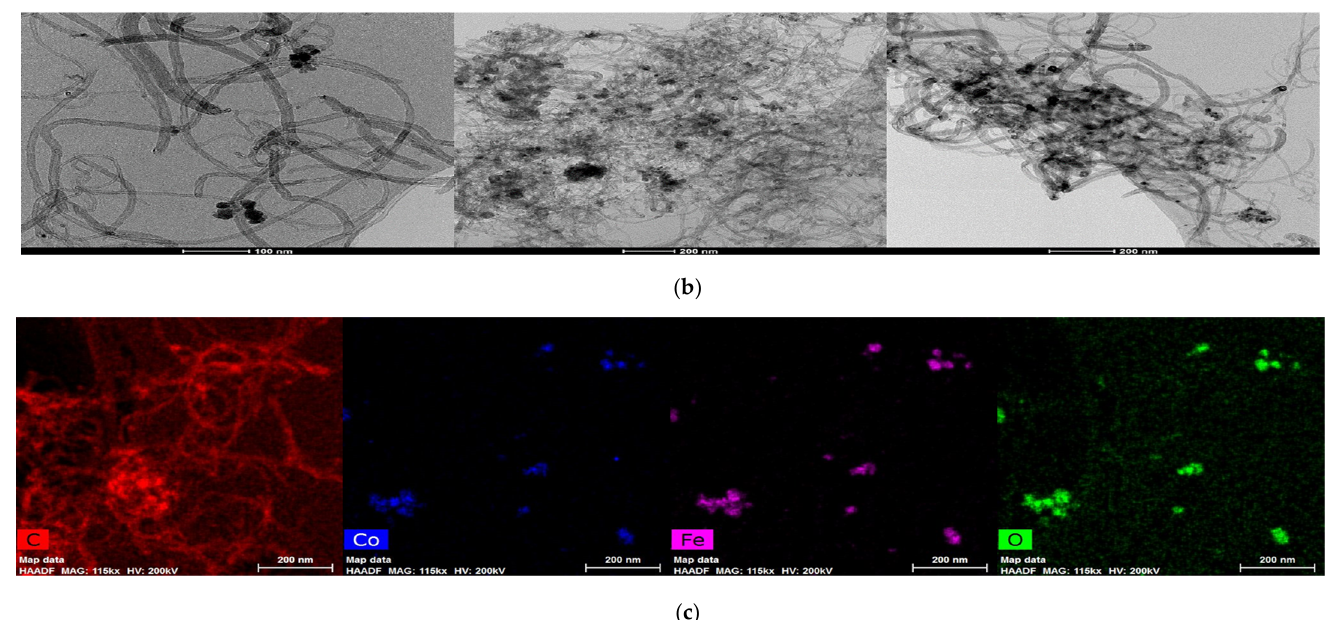
Figure 2. ( a ) SEM images for CNT with cobalt-iron oxide nanoparticles. ( b ) TEM images for CNT with cobalt-iron oxide nanoparticles. ( c ) Elemental mapping of cobalt iron oxide nanoparticles.